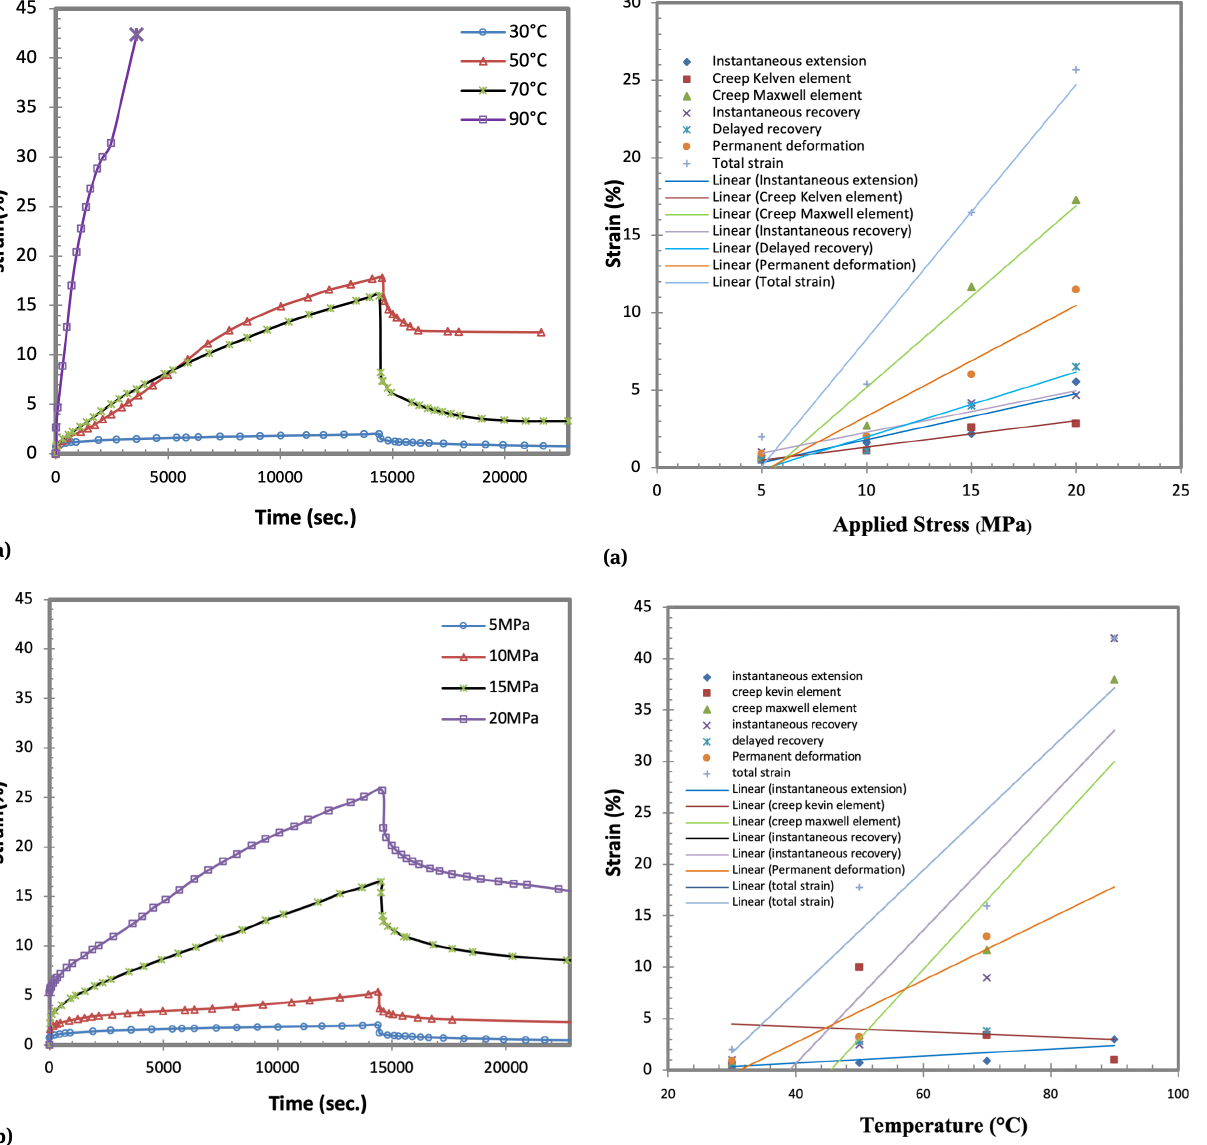
Figure 4: Creep and creep recovery behavior of Epoxy/6% PSR blend